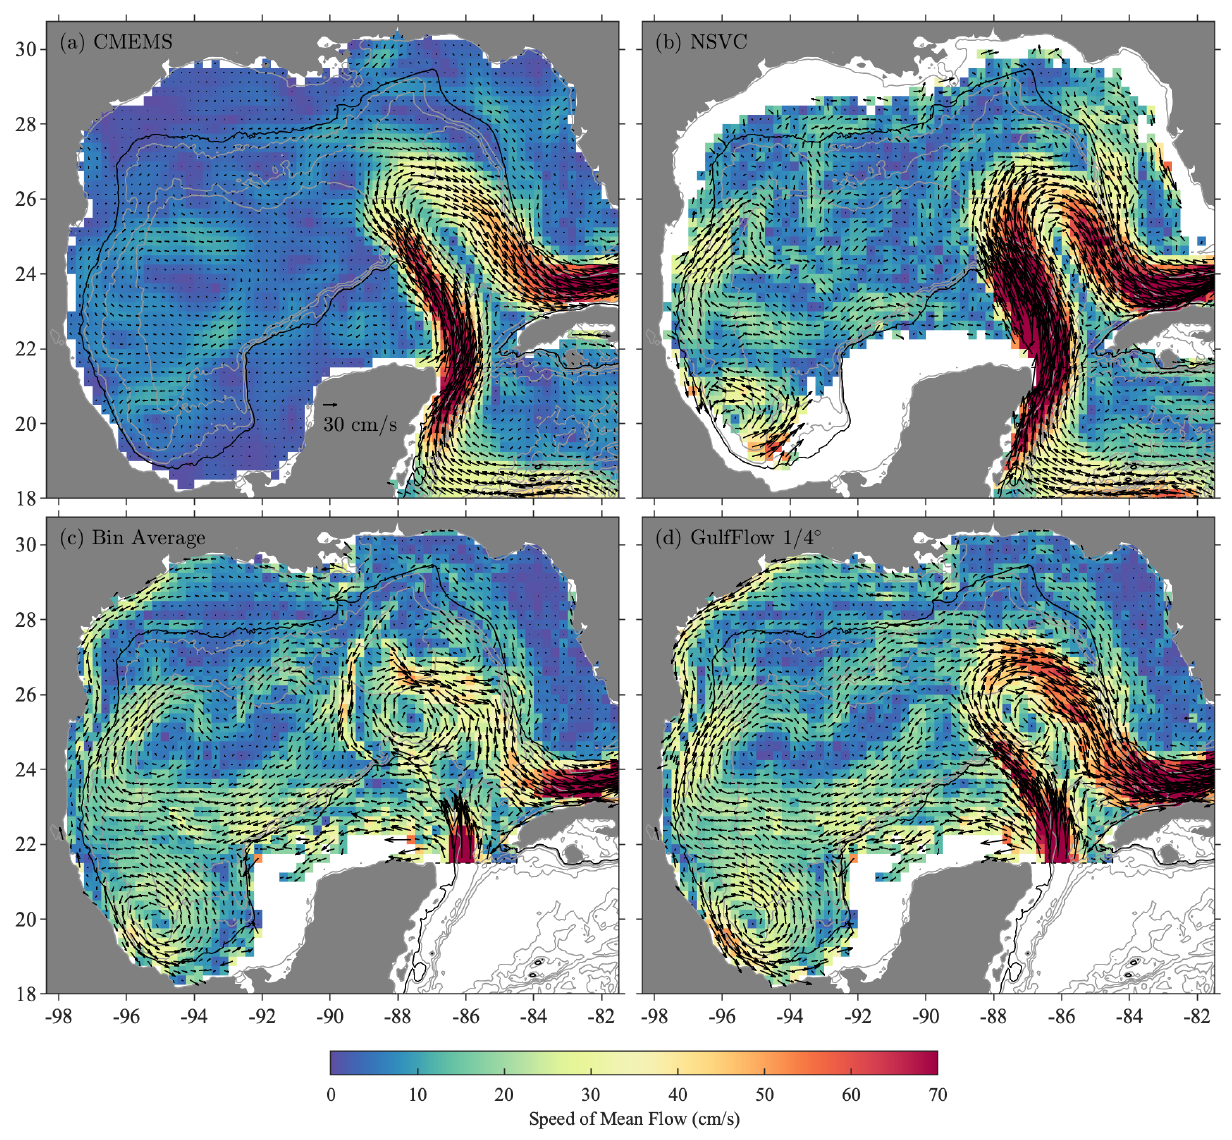
Figure 2. The mean surface circulation in the Gulf of Mexico in 1 / 4 ◦ bins from (a) CMEMS satellite altimetry, (b) the global climatology of Laurindo et al. (2017) using data from NOAA’s Global Drifter Program, (c) a direct bin-averaging of all data in the GulfDriftersAll dataset, and (d) the time mean of monthly data from the GulfFlow-1 / 4 ◦ product, equivalent to a two-step temporal averaging of the GulfDriftersAll dataset. The colored shading gives the speed of the time-mean flow, also proportional to the length of the arrows. The scale for the arrows is shown in panel (a) . For presentational clarity, arrows are shown on a decimated 3 / 4 ◦ grid. Bathymetric contours in this and following plots are as in Fig.